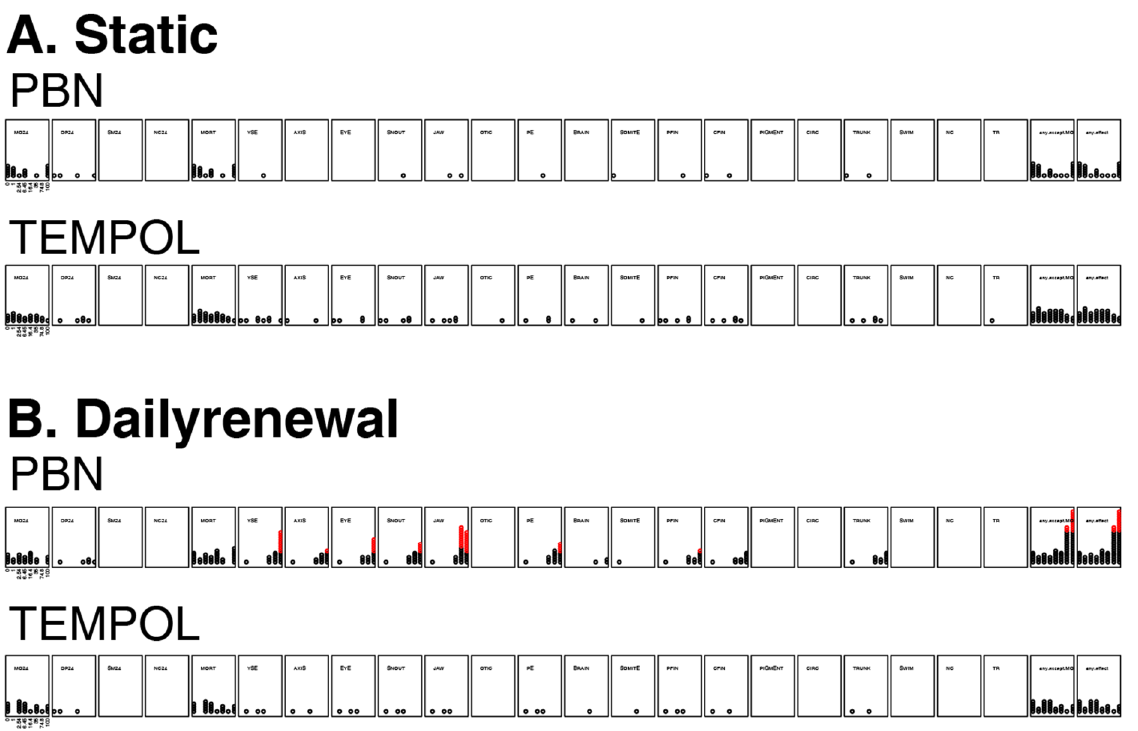
Figure 5. Incidence of overt toxicity responses to ( A ) static exposures and ( B ) daily renewal of PBN and TEMPOL at 24 and 120 hpf. MO24 = Mortality, DP24 = delayed development progression at 24 hpf, MORT = total mortality at five days. Two summary endpoints indicate individuals with any morbidity (any.except.MO), and any morbidity + mortality exhibited (any.effect). The other panels represent the morphological endpoints assessed. Each affected individual is illustrated as a circle and, once a statistical threshold is passed, the individual is depicted as red. YSE: yolk sac edema; AXIS: bent axis; EYE: abnormal eyes; SNOUT: abnormal snout; JAW: jaw; PE: pericardial edema and PFIN: pectoral